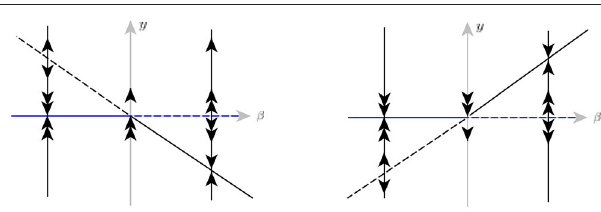
FIGURE 4 | Transcritical singularity bifurcation of Equation (13): s > 0 (left); s < 0 (right). Both feature a transition from an incoming to an outgoing singularity as β changes from the negative to the positive, where β changes according to Equation (17). The dashed (solid) lines indicate unstable (stable) equilibrium and singularity